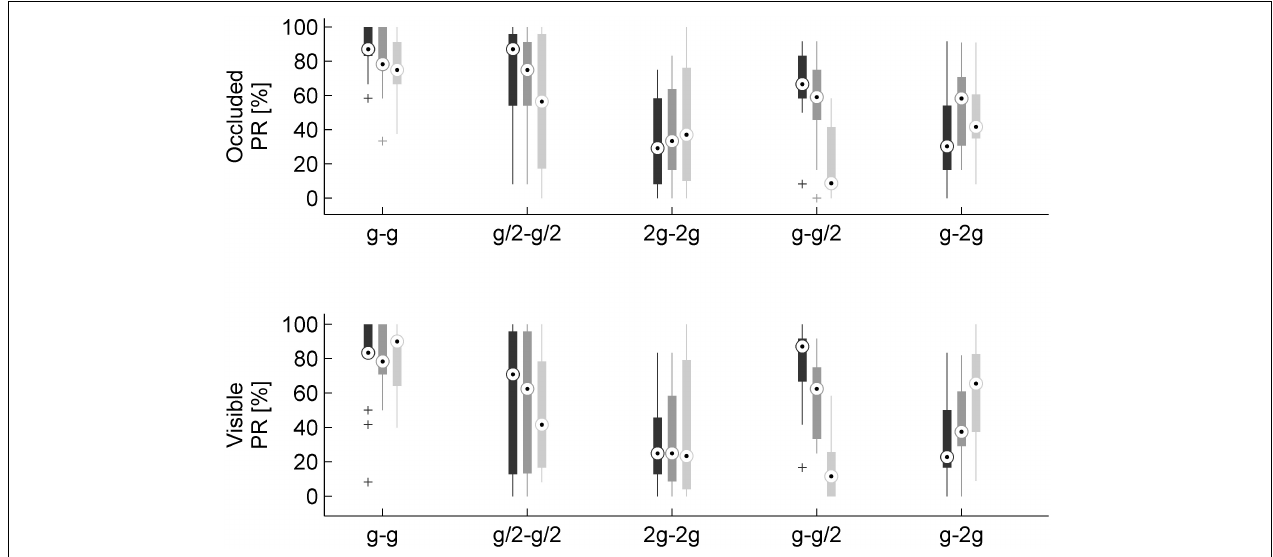
FIGURE 6 | Perception rates of natural motion for each gravity condition, visual condition, and traveled distance on the incline ( n = 16 subjects). Different gray levels denote different traveled distances: 0.546, 1.093, and 2.186 m, dark to light. Other conventions as in Figure 5 .